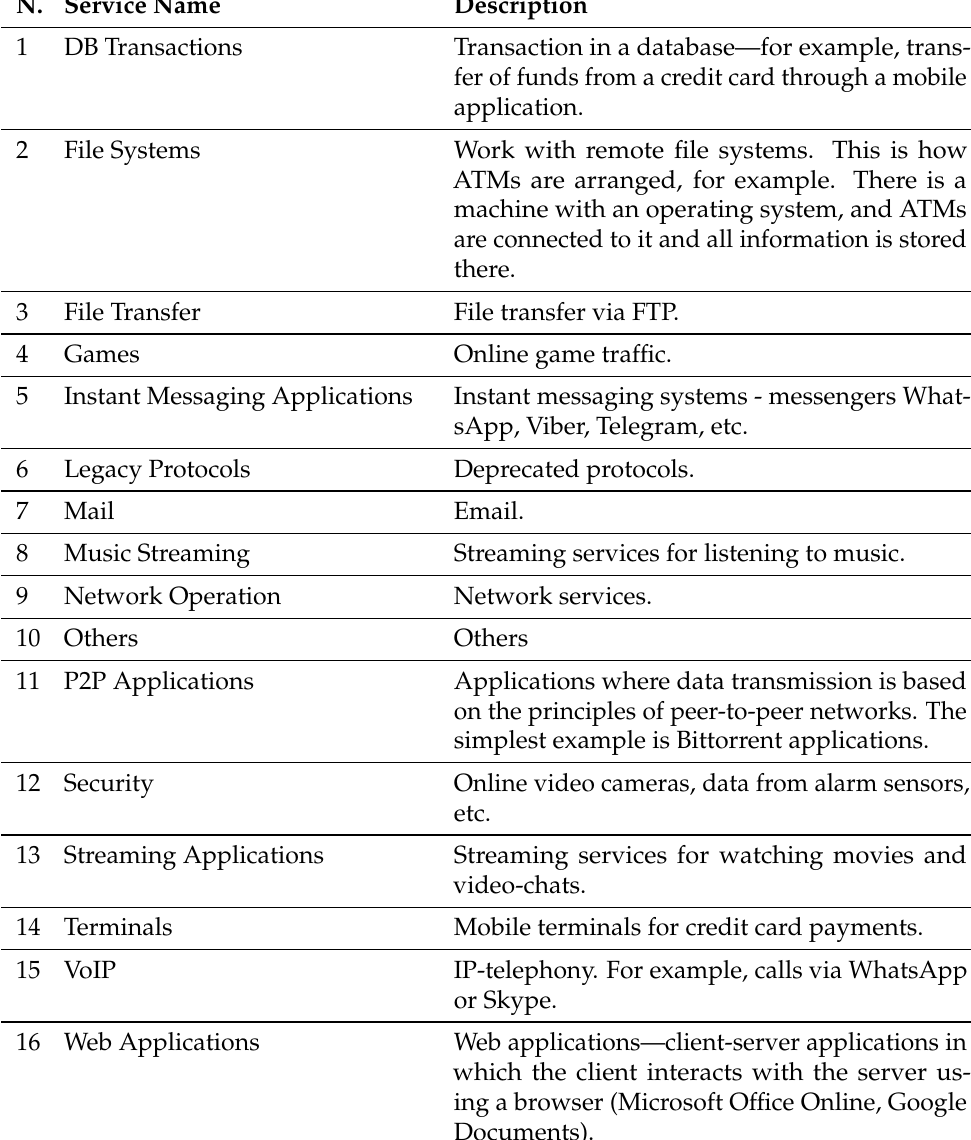
Table 2. Description of service